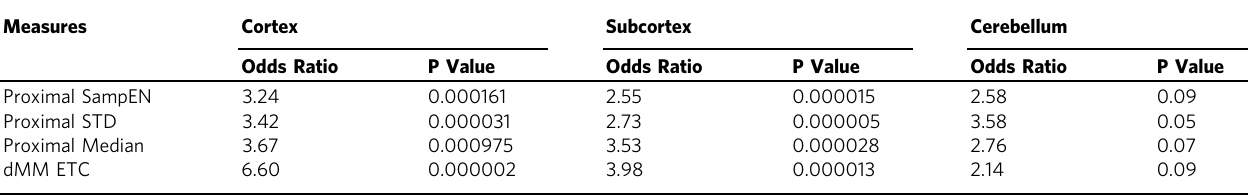
Table 1 Results for proximal and distal measures for the cortex, subcortex and cerebellum.